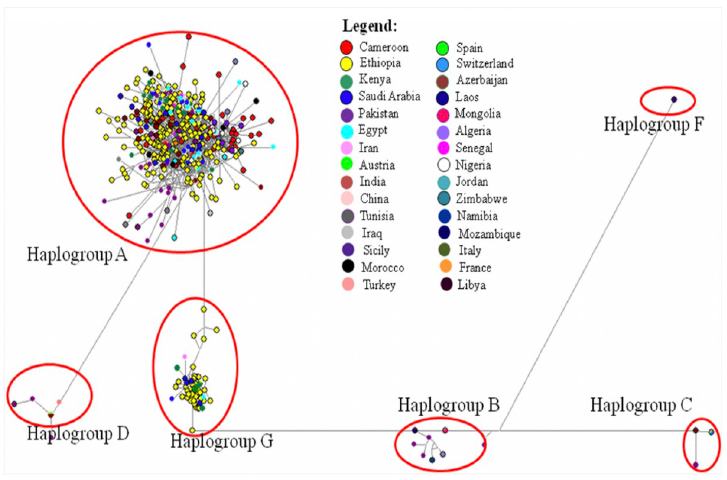
Fig 3. Median-joining (MJ) network graph of Cameroon goat populations and of reference haplotypes from different